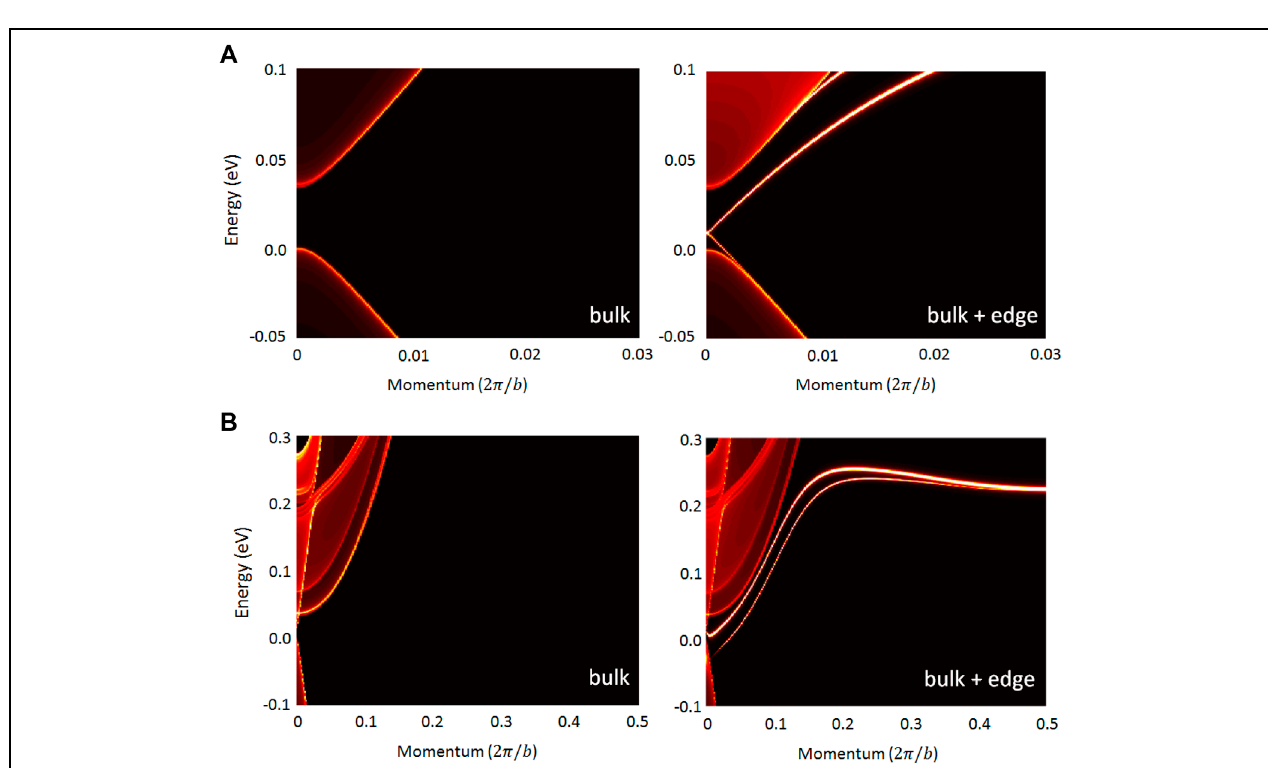
FIGURE 5 | The edge band structures along y -direction of single-layer (A) TiPI with 7% strain and (B) TiAsI with 2% strain. The left (right) panel displays the bulk (bulk plus edge) components of the band structure. The topological edge states of TiPI cross at Γ while those of TiAsI cross at Y .